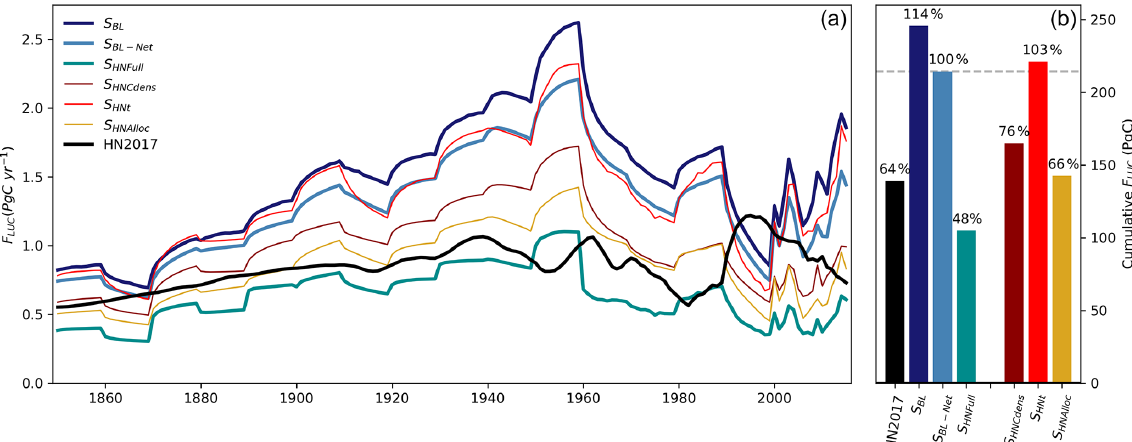
Figure 2. Global F LUC between 1850 and 2015 (a) from the two bookkeeping model estimates in GCB2019 (HN2017 in black and S BL for BLUE in dark blue), the BLUE simulations with net LUC transitions and standard BLUE parameterisation (light blue, S BL-Net , used as reference for all subsequent BLUE runs) and using all tested HN2017 parameterisations together (cyan, S HNFull ). The factorial simulations with only one set of parameters changed are shown in thin lines ( S HNCdens in dark red, S HNt in red, S HNAlloc in yellow). The corresponding cumulative totals between 1850 and 2015 are shown in panel (b) , and values relative to S BL-Net are shown by the numbers above